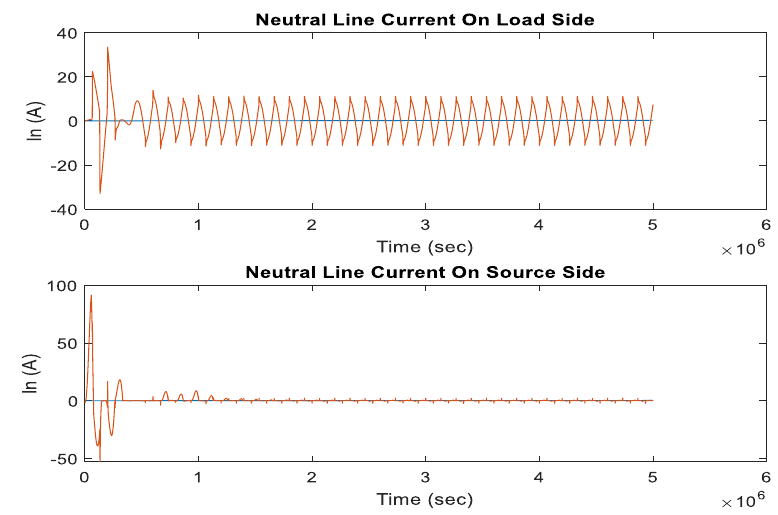
Figure 27. Neutral Line Current with Simulated ANN Based Filter.